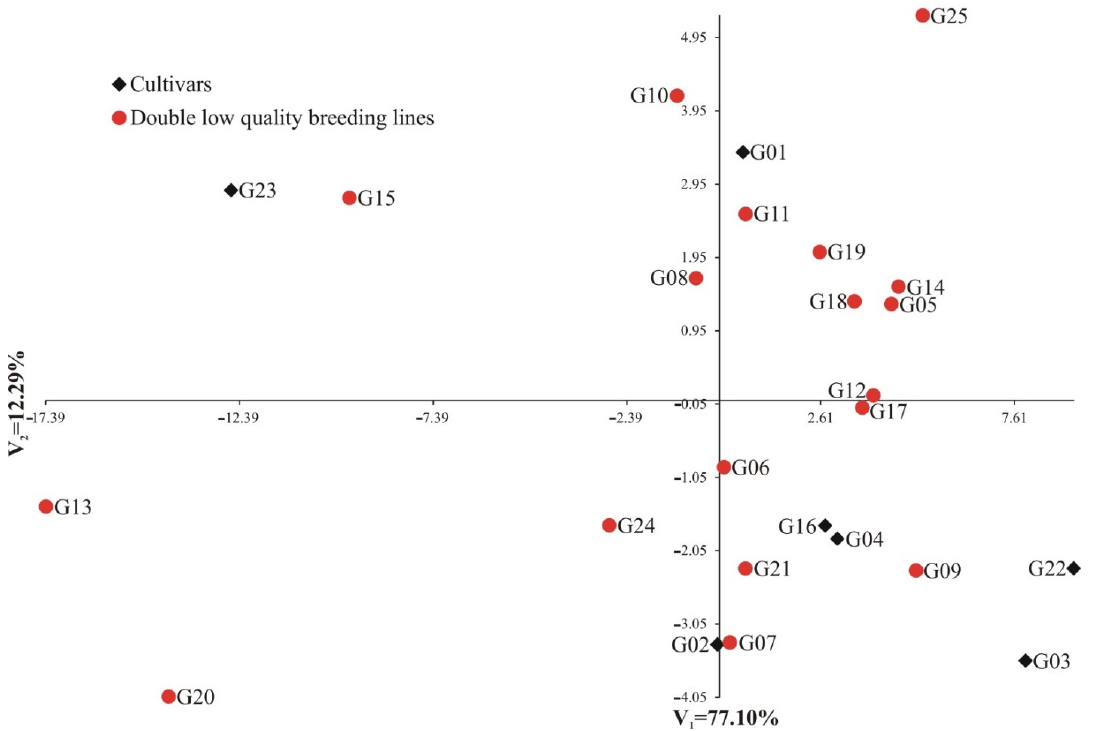
Figure 7. Distribution of 25 genotypes of winter oilseed rape ( Brassica napus L.) in the space of the first two canonical variates in Ł agiewniki 2015.